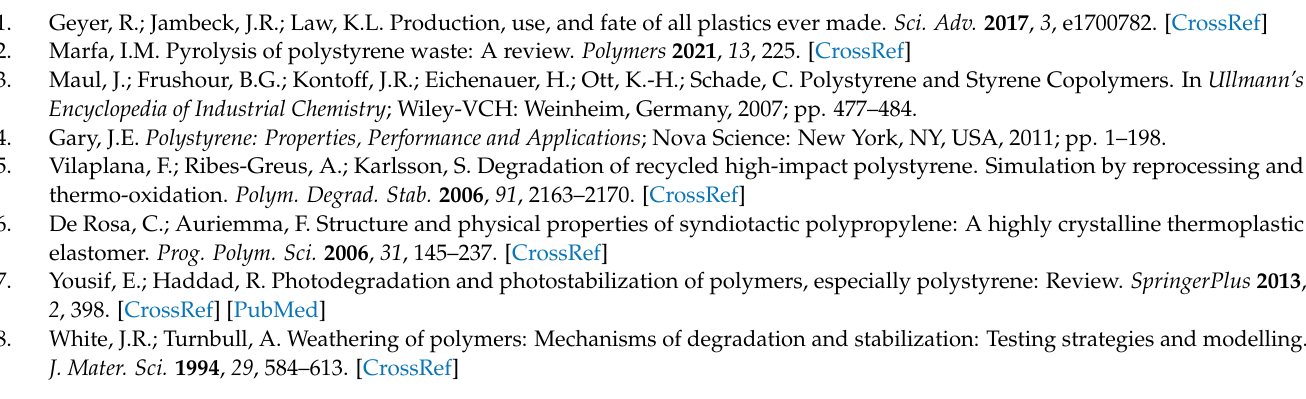
complex, Figure S2: FTIR spectrum of ibuprofen–Co complex, Figure S3: FTIR spectrum of ibuprofen– Ni complex, Figure S4: UV–vis spectrum of ibuprofen–Mn complex, Figure S5: UV–vis spectrum